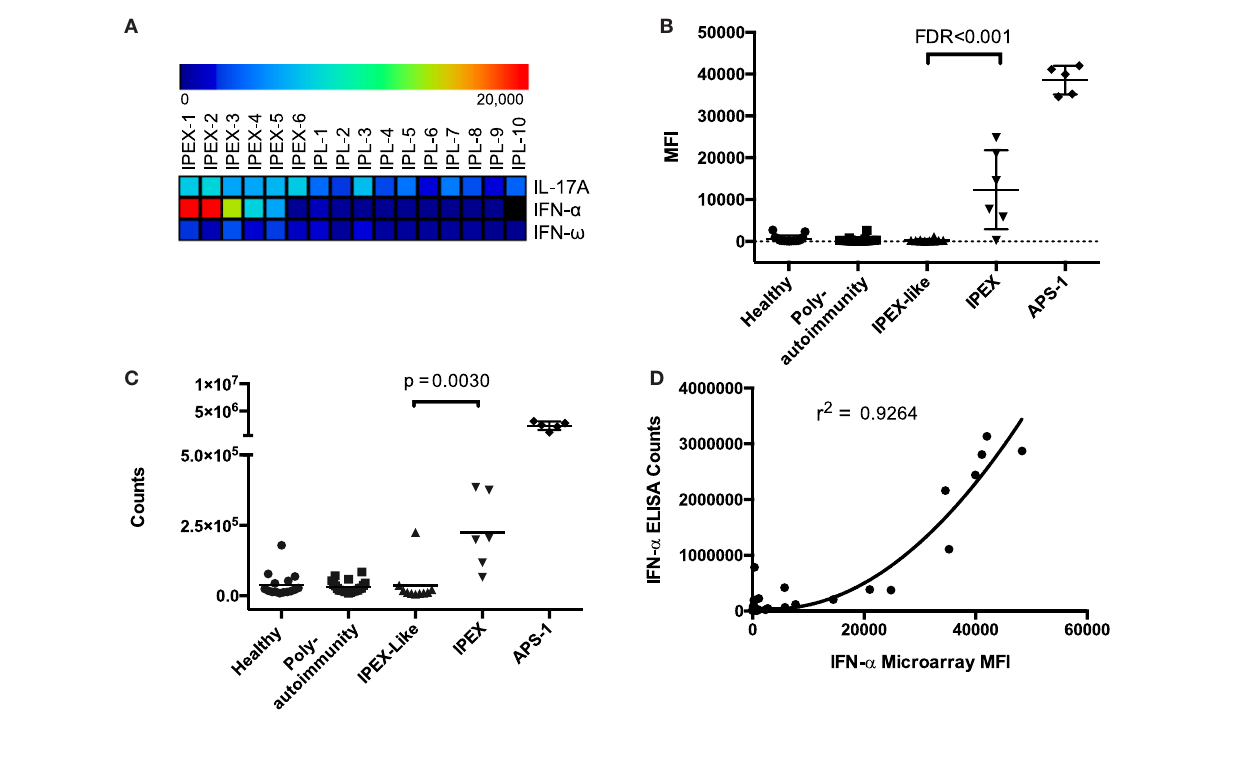
FigUre 1 | Antigen microarrays identify anti-cytokine autoantibodies (ACAAs). (a) Significance analysis of microarrays identifies ACAAs enriched in immunodysregulation polyendocrinopathy enteropathy X-linked (IPEX) compared to IPEX-like disease (IPL) (false discovery rates < 0.001). (B) ACAA mean fluorescence intensity values against interferon- α (IFN- α ) in all patients studied as measured by antigen microarray. (c) ACAA counts against IFN- α in all patients studied as measured by indirect immunoassay ( p = 0.003 Mann–Whitney) (D) Correlation of IFN- α ACAA values as measured by microarray compared to indirect immunoassay ( r 2 = 0.924 using quadratic